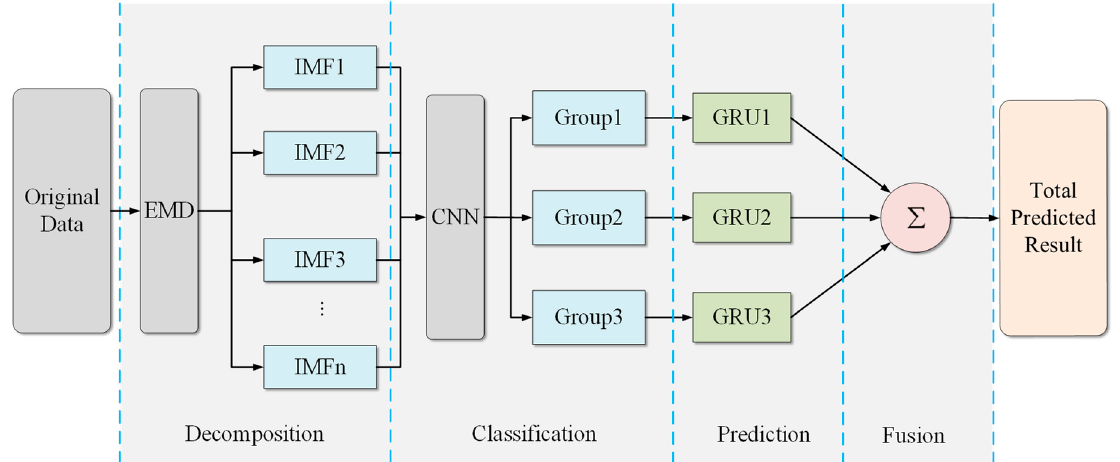
Figure 6. Flowchart of a PM2.5 hybrid predictor for an air quality monitoring system.